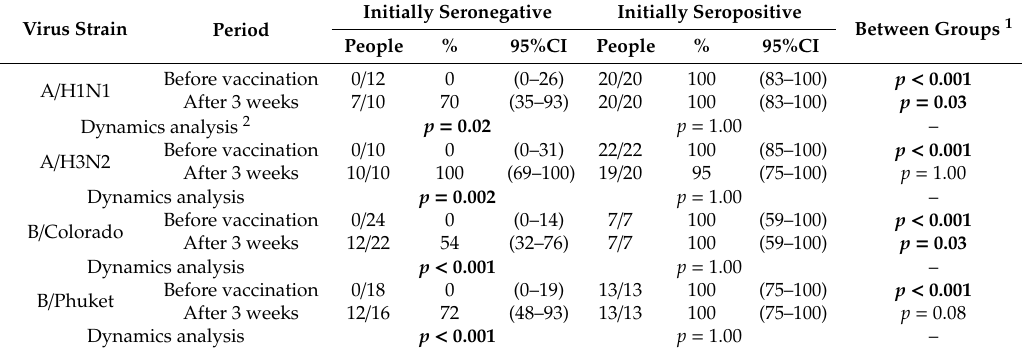
Table 1. Seroprotection levels given the initial level of antibodies in the group of healthy participants.